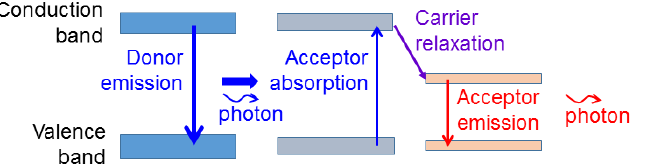
Figure 2. Schematic illustration of a conventional photon down-conversion process, including the four steps of donor emission, acceptor absorption, carrier relaxation, and acceptor emission.